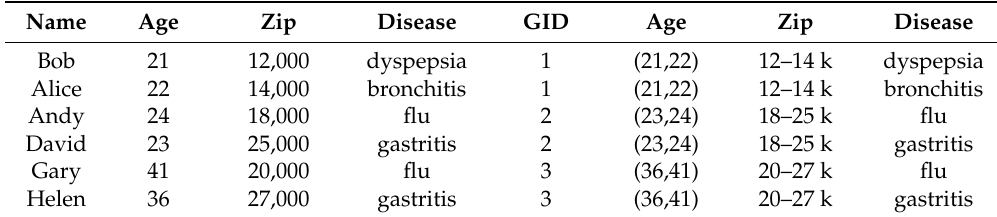
Table 1. Diagnosis records and anonymous generalization